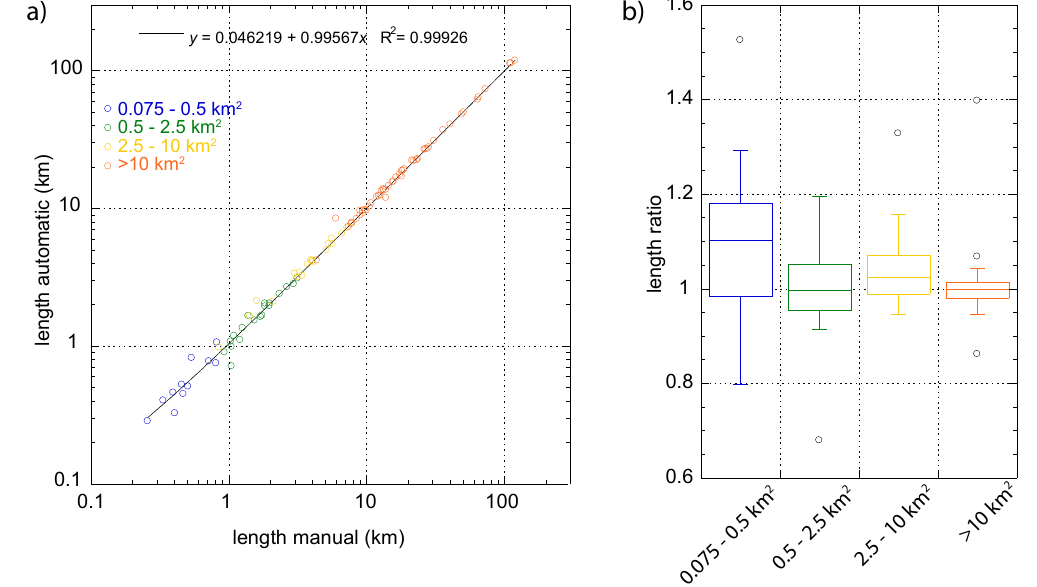
Figure 6. (a) Linear regression of manually ( L m ) and automatically ( L a ) measured glacier length for 100 randomly selected glaciers. (b) Length ratio L a /L m displayed for four glacier size classes in box plots. Whiskers refer to 1.5 interquartile range.